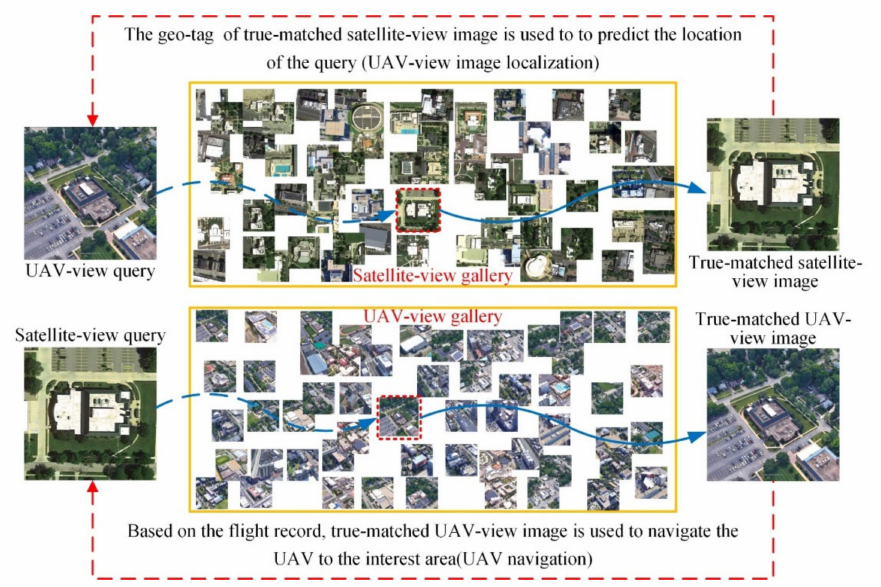
Figure 3. A schematic diagram of cross-view image matching for UAV image localization and UAV